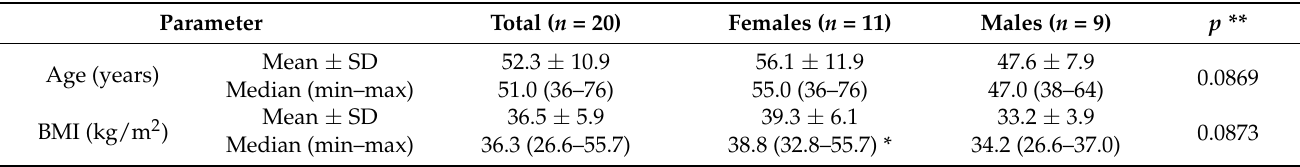
Table 1. The general baseline characteristics of the studied group of participants.